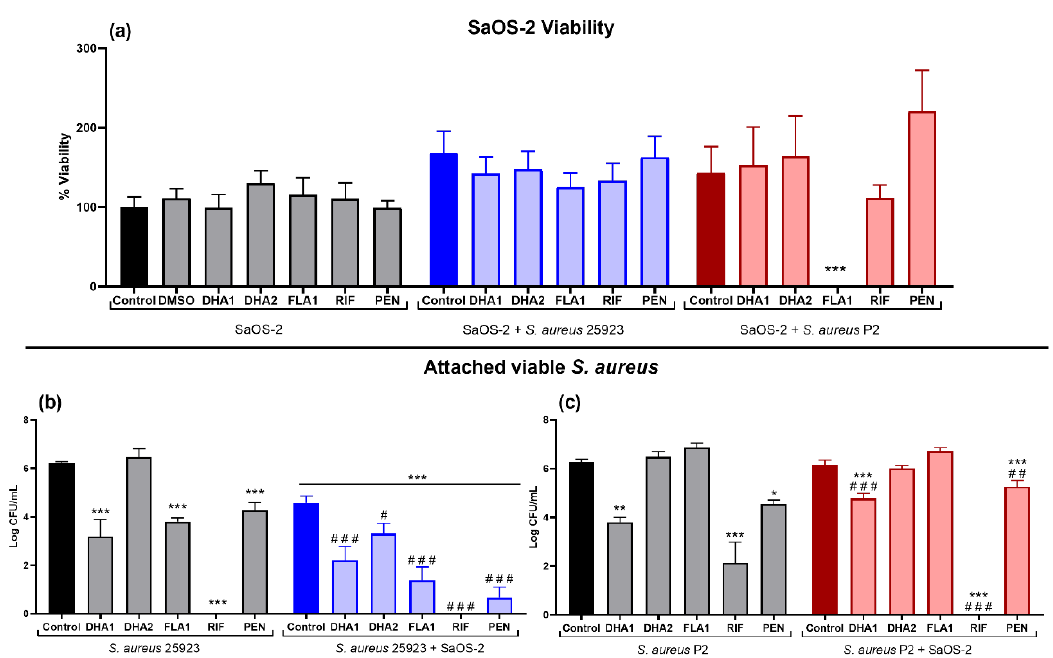
Figure 4. E ff ect of the two DHA derivatives ( DHA1 and DHA2 ), the flavonoid-derivative ( FLA1 ), and two control antibiotics ( RIF and PEN ) on the competitive colonization assay performed in titanium coupons. ( a ) Results corresponding to the viability of SaOS-2 cells when cultured on titanium coupons alone (SaOS-2, grey bars), or co-cultured with S. aureus ATCC 25923 (SaOS-2 + S. aureus 25923, blue bars), or P2 clinical S. aureus strain (SaOS-2 + S. aureus P2, red bars); ( b , c ) Results corresponding to the e ff ects on attached viable S. aureus measured when the ATCC 25923 ( b ) or P2 clinical S. aureus strain ( c ) was used. Percentage of viability of SaOS-2 cells was calculated with respect to untreated controls after 24-h incubation on titanium coupons, using glow luminescence signal resulting from ATP production by viable SaOS-2 cells. Viable counts (log of CFU / mL) of S. aureus ATCC 25923 or the clinical strain P2 were also measured after 24-h incubation on titanium coupons when co-cultured with SaOS-2 cells. “*” represents di ff erences with the corresponding monoculture control and “#” represents di ff erences with the corresponding co-culture controls (* p < 0.05; ** p < 0.01; *** p < 0.001) / (# p < 0.05; ## p < 0.01; ### p < 0.001). Results are expressed as mean ± SEM of three technical replicates in experiments repeated three